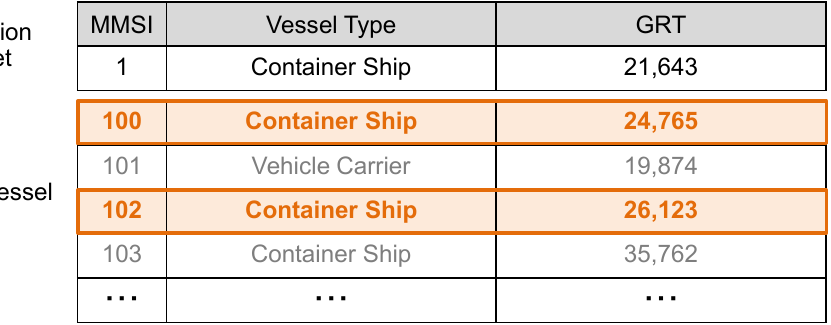
Figure 4. Overview of vessel routing procedure.